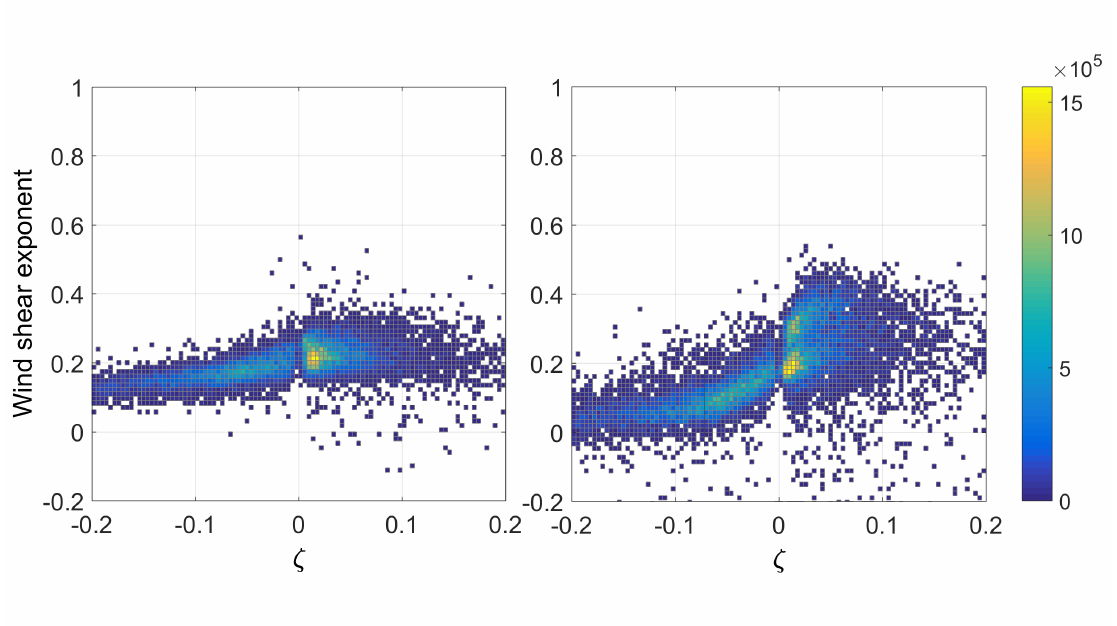
Figure 8. ζ and wind shear exponent (m) distribution for 30 min